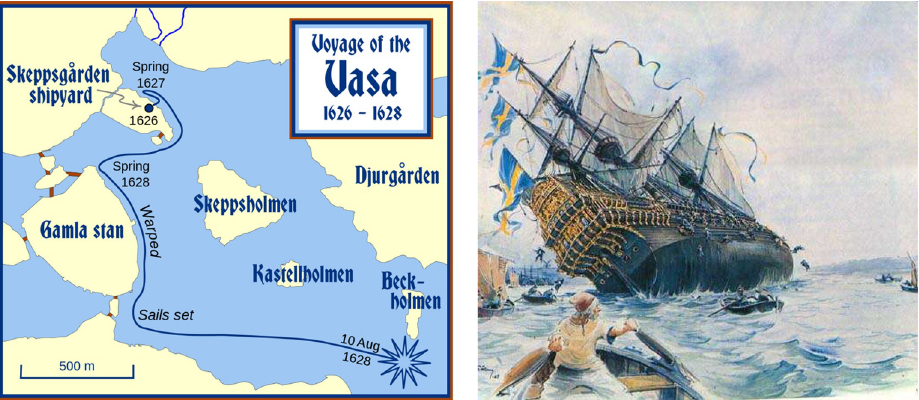
Fig. 17. – Left: the maiden journey of the Vasa. Right: the sinking of the great warship